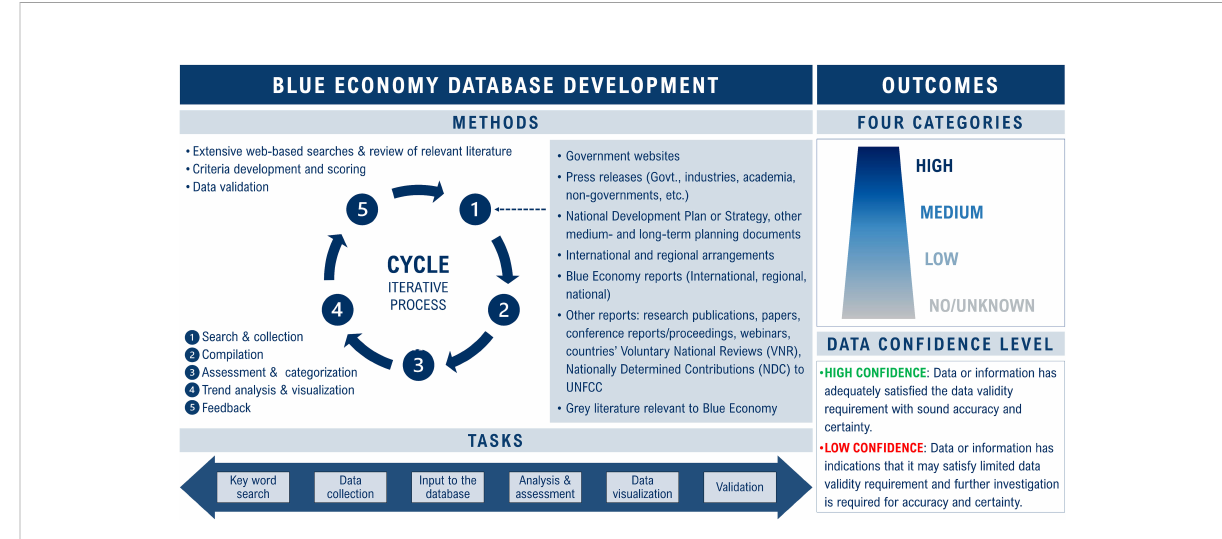
FIGURE 1 Description of the